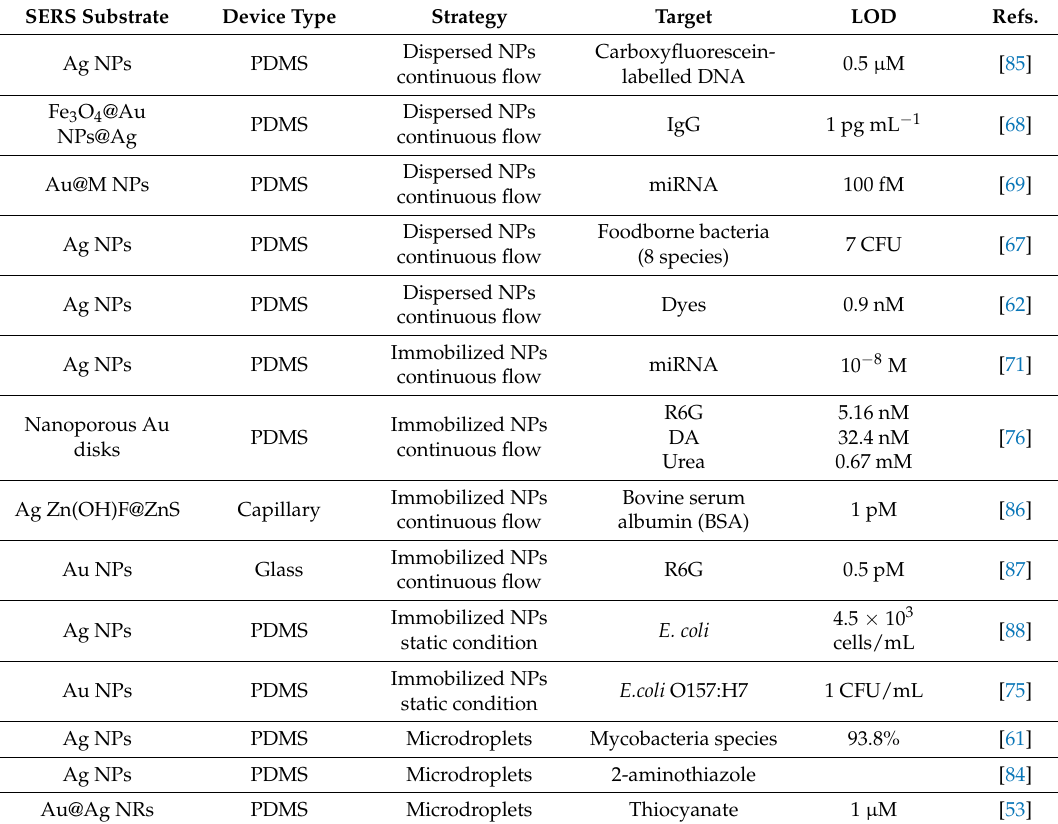
Table 1. Additional examples of lab-on-a-chip (LOC)-surface-enhanced Raman scattering (SERS) based sensors for various targets. LOD—limit of